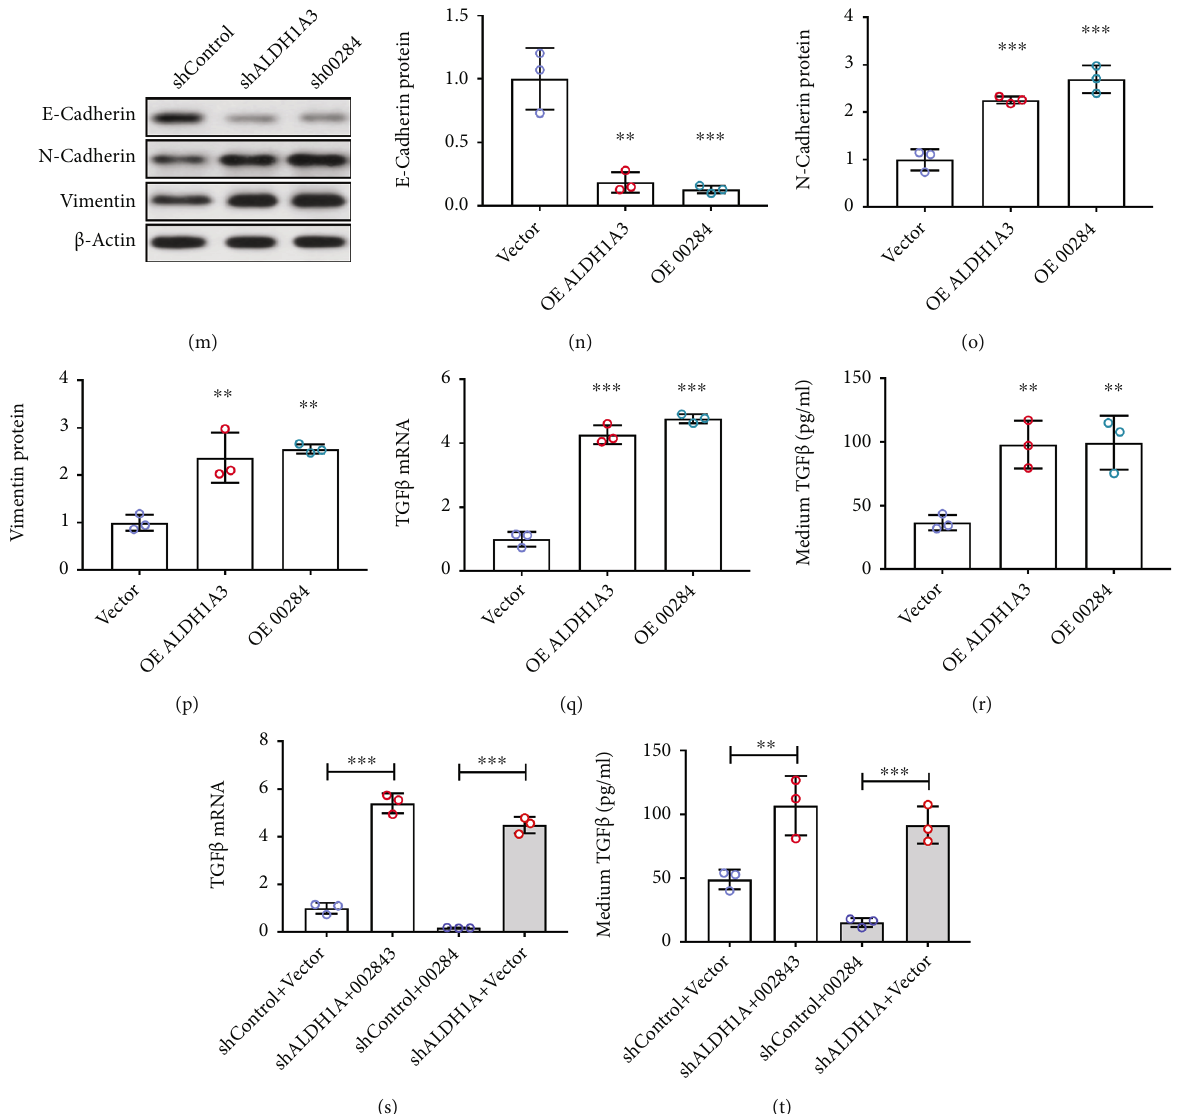
Figure 4: ALDH1A3 – Linc00284 axis promoted EMT via regulating TGF β level. The mRNA level of E-cadherin (a); N-cadherin (b); and vimentin (c) in Linc00284- and ALDH1A3-silenced SW480 cells was determined by qPCR analysis. The protein level of E-cadherin ((d) and (e)), N-cadherin ((d) and (f)), and vimentin ((d) and (g)) in Linc00284- and ALDH1A3-silenced SW480 cells was determined by western blot analysis. (h) The mRNA level of TGF β in Linc00284- and ALDH1A3-silenced SW480 cells was determined by qPCR analysis. (i) The protein level of TGF β in Linc00284- and ALDH1A3-silenced SW480 cells medium was determined by ELISA. The mRNA level of E-cadherin (j); N-cadherin (k), and vimentin (l) in Linc00284- and ALDH1A3-overexpressed SW480 cells was determined by qPCR analysis. The protein level of E-Cadherin ((m) and (n)), N-Cadherin ((m) and (o)), and Vimentin ((m) and (p)) in Linc00284- and ALDH1A3-overexpressed SW480 cells was determined by western blot analysis. (q) The mRNA level of TGF β in Linc00284- and ALDH1A3-overexpressed SW480 cells was determined by qPCR analysis. (r) The protein level of TGF β in Linc00284- and ALDH1A3-overexpressed SW480 cells medium was determined by ELISA. Overexpression of Linc00284 rescued the e ff ect of ALDH1A3 silence on TGF β mRNA level in SW480 cell (s) and protein level (t) in medium (3 wells per